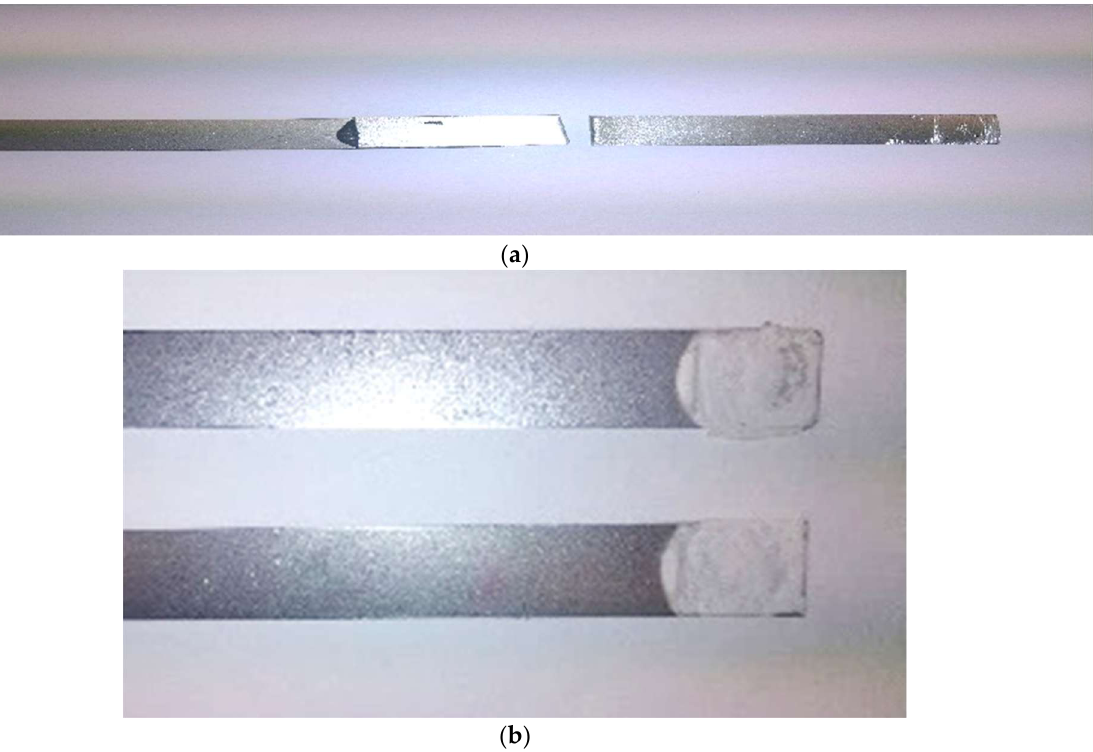
Figure 3. Comparison of ruptured specimens; ( a ) high-strength adhesive; ( b ) hybrid adhesive used in tests.